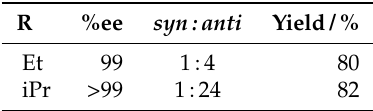
Figure 1. ( a ) The proline-catalyzed enantioselective aldol reaction studied in this work, see [33]. Selectivity and yield are given in Table 1. * denotes the two newly created stereocenters. ( b ) The four possible reaction products of the aldol reaction between two aldehydes. With proline catalysis, the preferred product is always the (S)-anti configuration (lower-right corner) [33]. Table 1. Experimentally determined enantiomeric excess, syn:anti selectivity, and yield of the aldol reaction shown in Figure 1a for R = Et, iPr; taken from Ref.